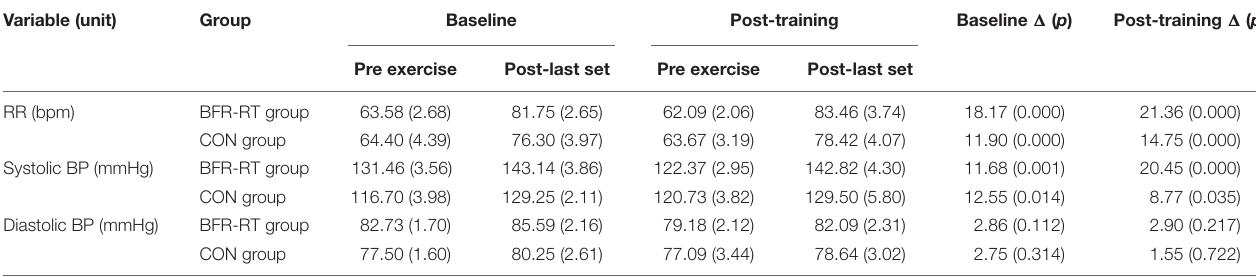
TABLE 3 | Acute hemodynamic exercise response at baseline and after the intervention period. Variable (unit) Group